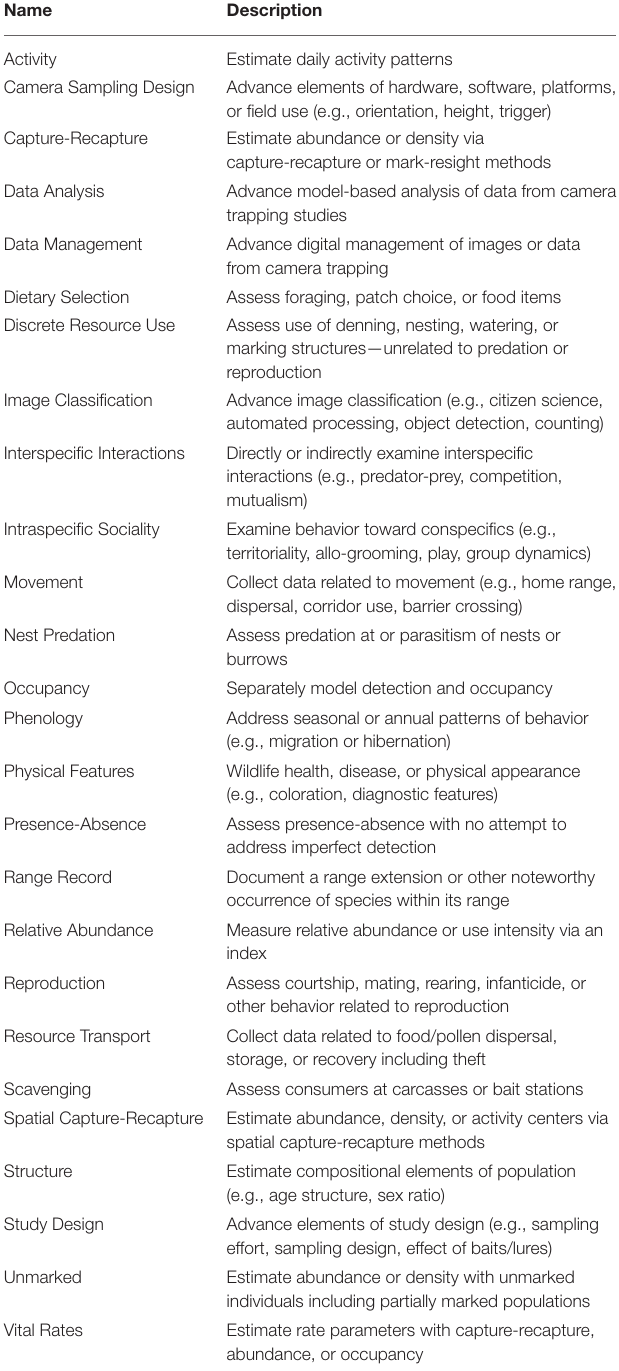
TABLE 1 | Names and descriptions of the 26 topic categories for which camera-trapping studies were scored.